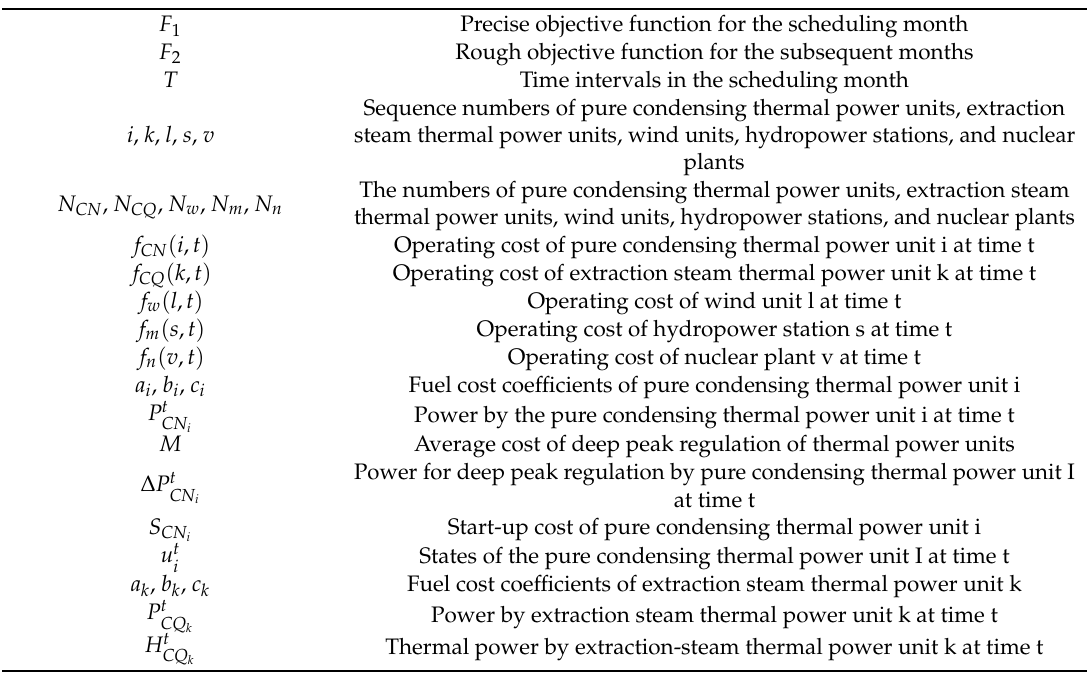
Table A1. Variable comparison